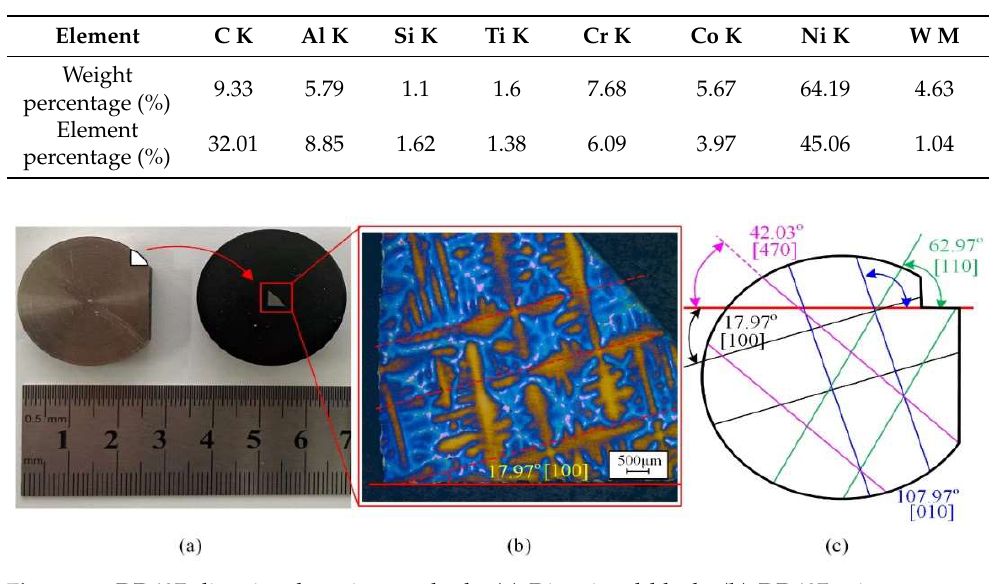
Figure 1. DD407 directional cutting method. ( a ) Directional block, ( b ) DD407 microstructure, ( c ) Specific crystal directions designation on (001) plane of DD407.